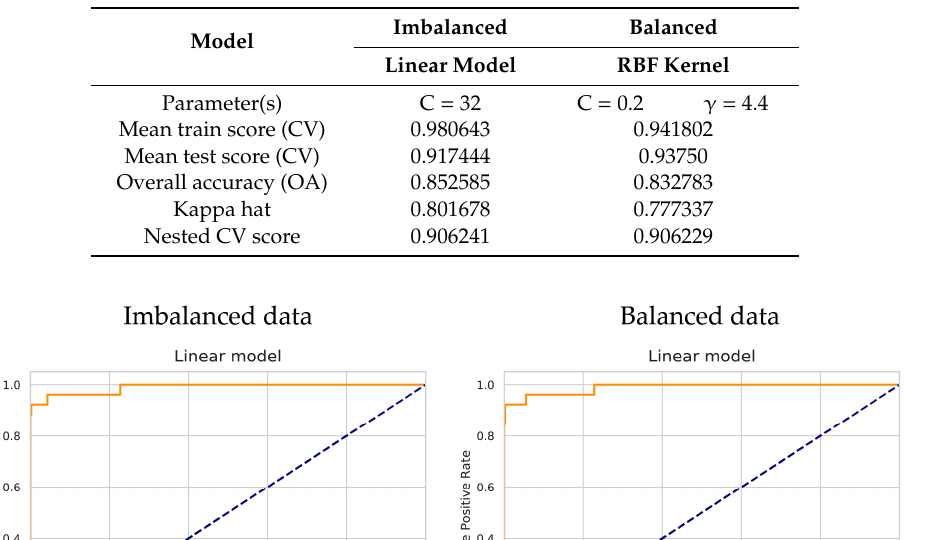
Table 4. Classification Performance Summary for the Two Models Built.